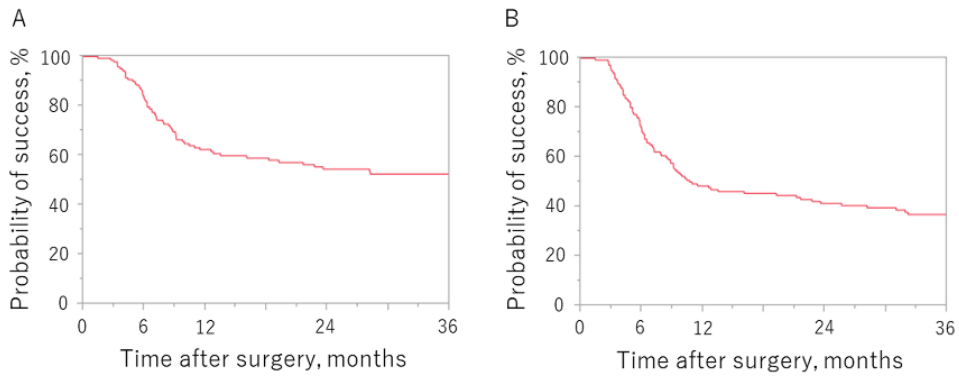
Figure 1. Kaplan–Meier survival curves according to which failure criterion was used. Criterion ( A ):